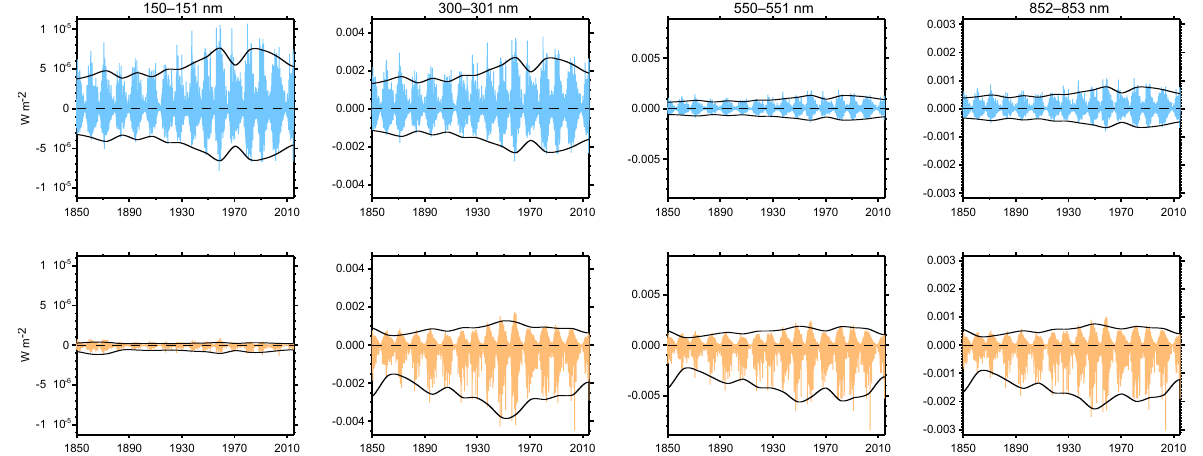
Figure H2. D + (top, light blue) and D − (bottom, light red) components of SSI at wavelength bins centered at 150.5, 300.5, 550.5, and 852.5nm (from left to right). The corresponding scaling functions SD(D + ) (top) and MAD(D − ) (bottom), multiplied by 3.5 and − 3 in the case of SD(D + ) (5 and − 15 in the case of MAD(D − )) are shown by black solid lines.